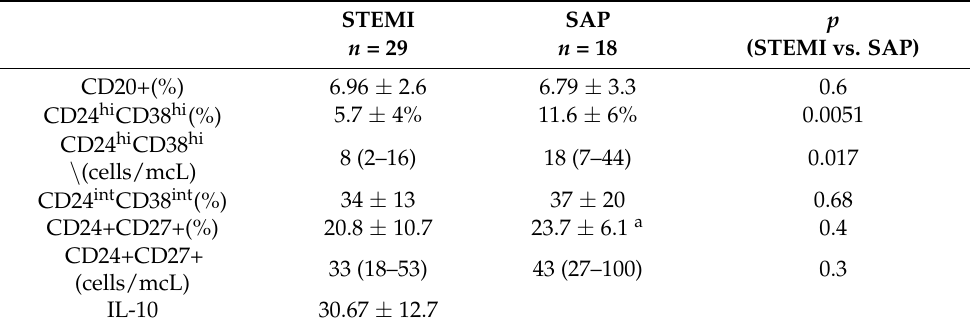
Table 2. Circulating regulatory B lymphocytes in patients with acute myocardial infarction and patients with stable angina